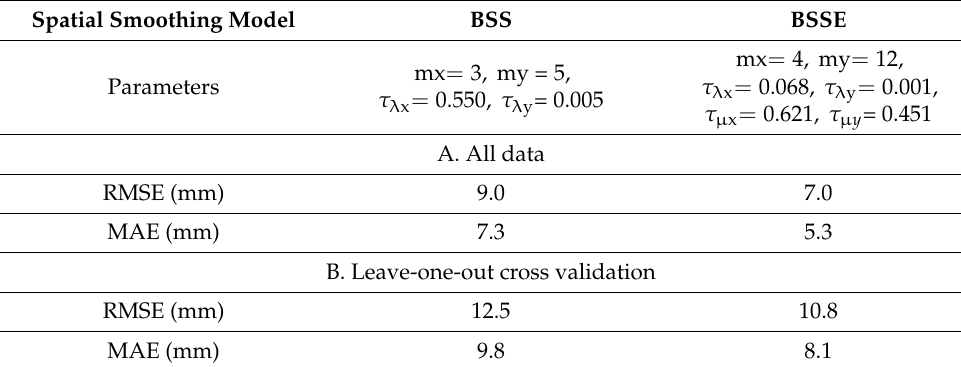
Table 1. Results from the BSS and BSSE models fitting.